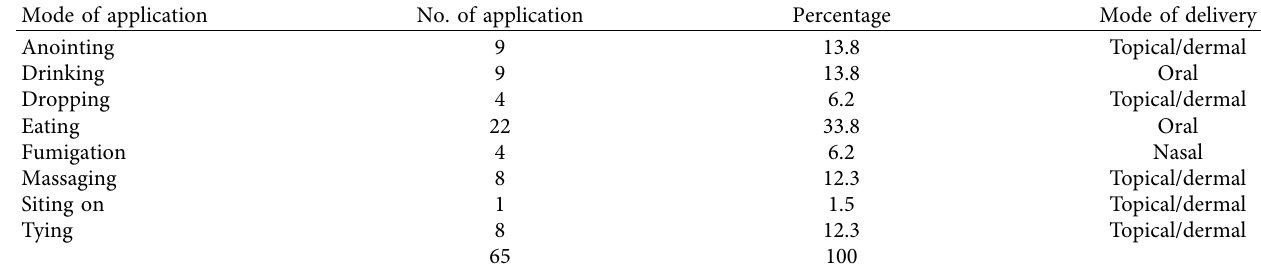
Table 2: Mode of application of traditional